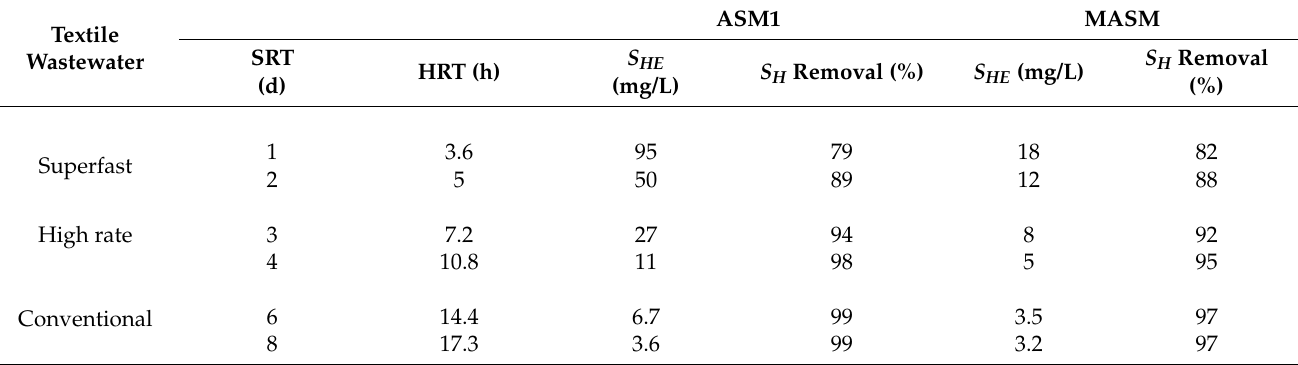
Table 5. S H removal in in ASM1 and MASM models operated at the same SRT values. Textile